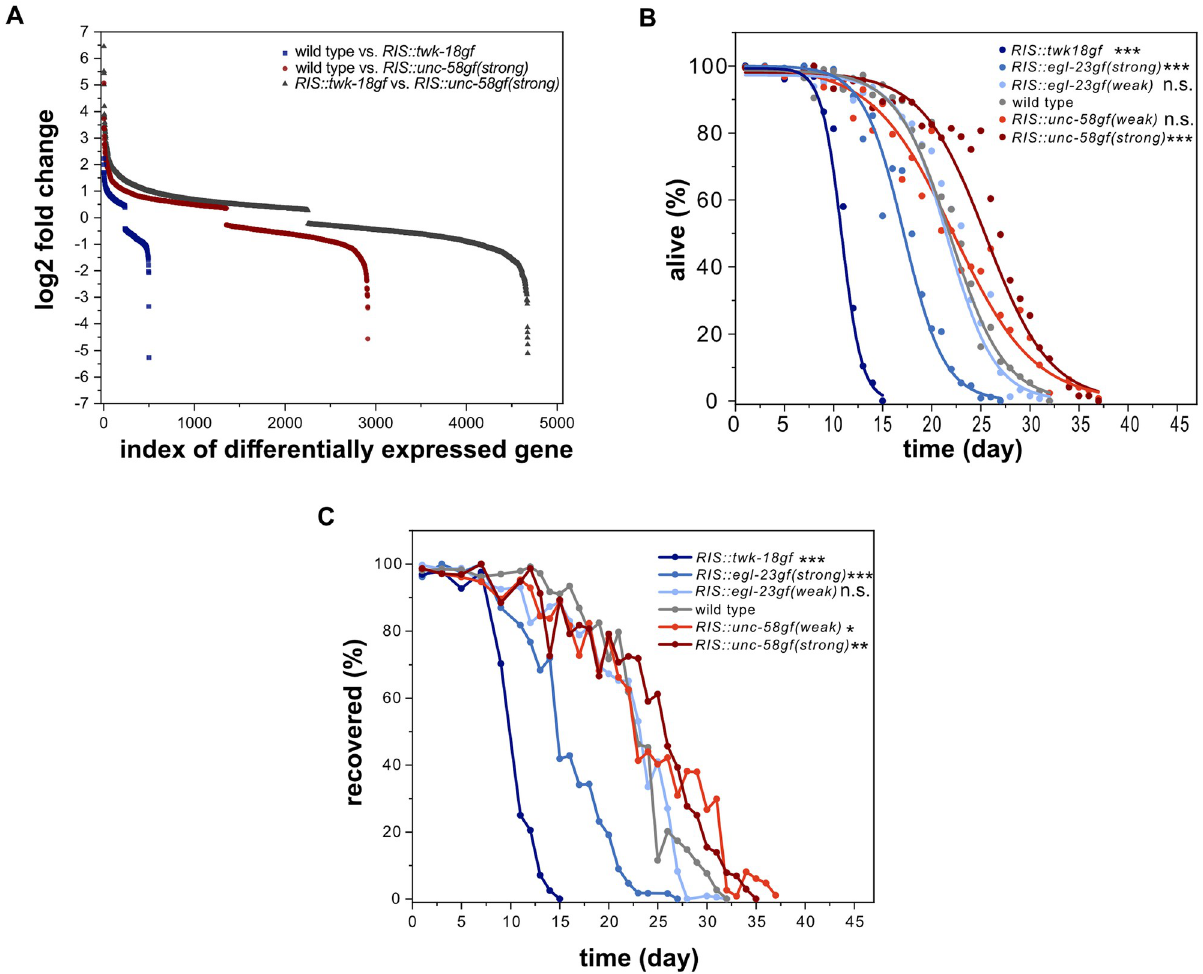
Fig 2. Survival of starvation-induced L1 arrest is a function of RIS activity. A) RIS :: twk-18gf and RIS :: unc-58gf(strong) strains cause divergent transcriptional profiles. Shown is the log2 fold change for all differentially expressed genes. A gene was counted as differentially expressed with an FDR < 0.05. According to our previously published results, RIS :: twk-18gf expressed 498 genes differentially compared with the wild type. RIS :: twk-18gf has been shown to be similar to aptf-1(gk794) [24]. RIS :: unc-58gf(strong) was shown to express 2913 genes differentially compared with the wild type [24]. Comparing RIS :: twk-18gf and RIS :: unc-58gf(strong) revealed 4676 differentially expressed genes. This analysis supports the view that these two strains have opposing transcriptional profiles and identifies 1910 additional genes that are potentially under the control of RIS activity (S5 Table). B) Strong inactivation significantly decreases survival in L1 arrest whereas strong activation prolongs survival (three-parameter logistic fit, see also S1 Table, Fisher’s Exact Test was conducted when 50% of wild-type worms were alive (day 22)). The p-values were FDR corrected with Benjamini- Hochberg procedure with a 5% false discovery rate. The plot includes data from three replicates. ��� p < 0.001. C) Recovery from L1 arrest depends on RIS activity with strong inactivation leading to a reduced recovery and constant activation leading to a prolonged ability to recover. For statistics, the Fisher’s Exact Test was conducted at the time when 50% of wild-type worms recovered (day 23). The p-values were FDR corrected with Benjamini- Hochberg procedure with a 5% false discovery rate. The plot includes data from two replicates. N.s. p > 0.05, � p < 0.05, �� p < 0.01, ��� p < 0.001. Fisher’s Exact